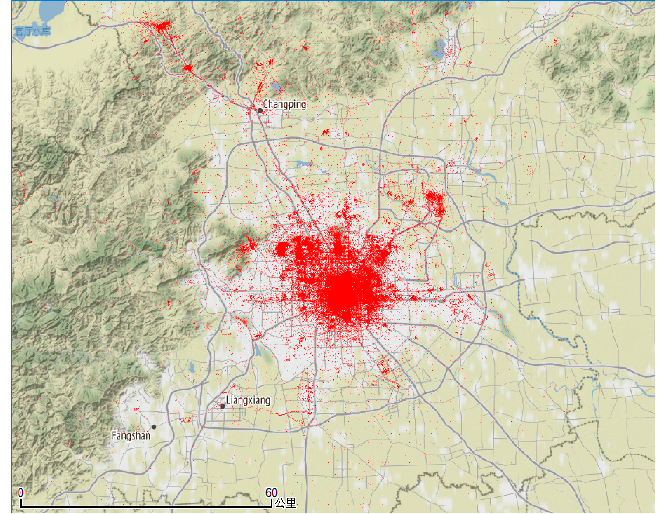
Figure 1. Flickr geo-coordinates’ distribution map.